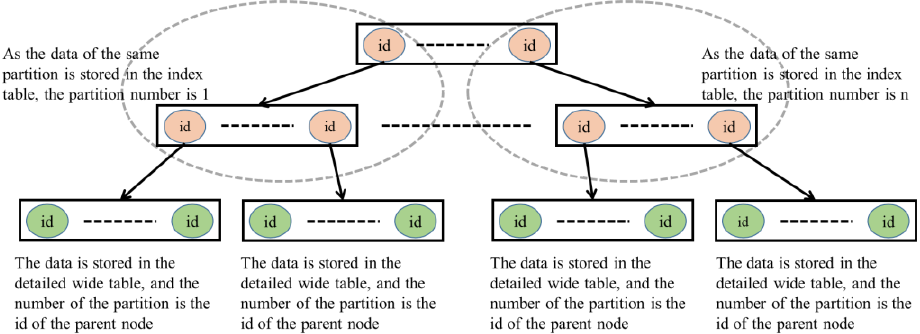
Figure 2 . Use R-Tree to build the logic of index table and detail